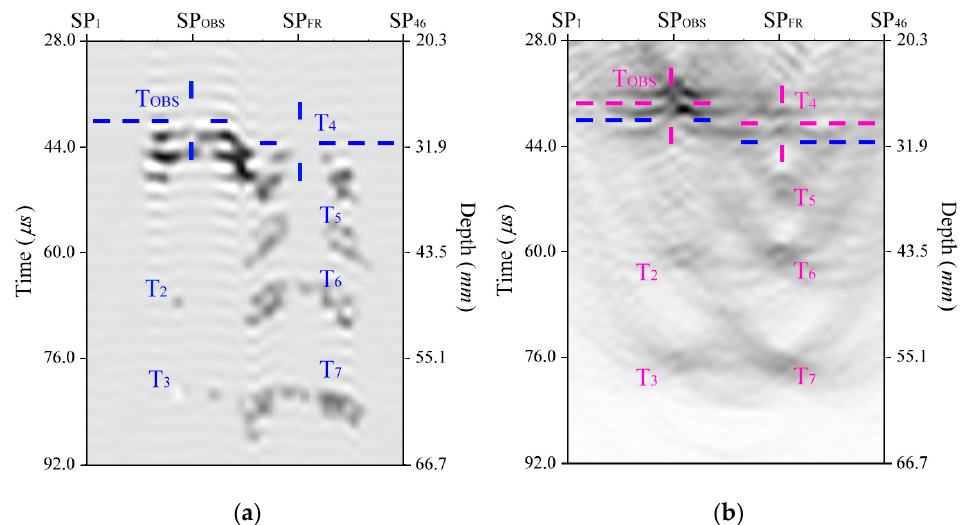
Figure 5. ( a ) Original pitch/catch scan data. Except for T 1, which is positioned too close to T OBS and falls within the anechoic zone, echo signals from the other targets are all detected. ( b ) Restored image of ( a ) which is processed by SAFT. The performance of SAFT in image restoration can be shown by the upward shift of the dark blue dashed line to the pink dashed line.